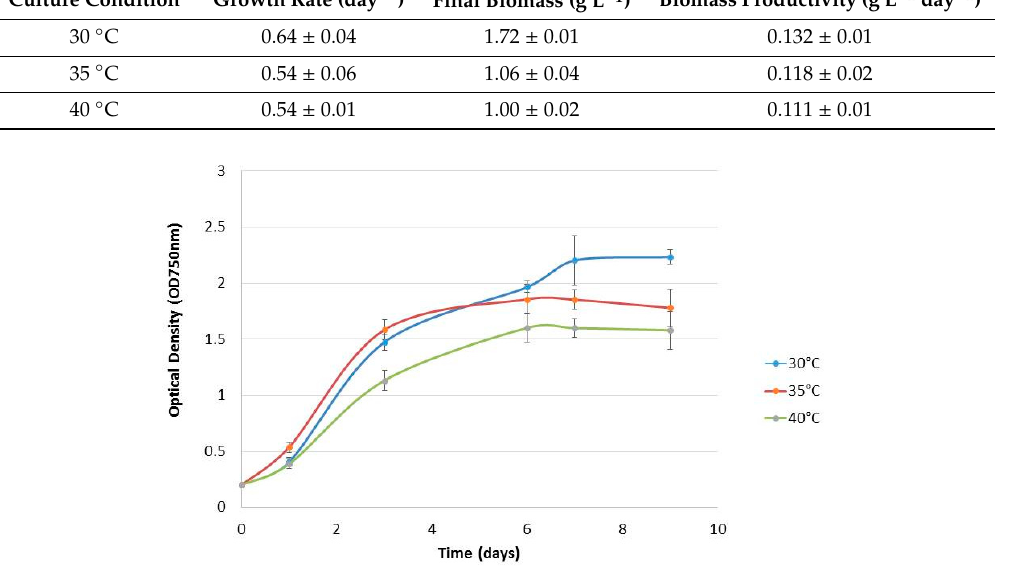
Figure 1. Growth curves of Chlorella sp. QUCCCM3 cultured under di ff erent temperatures. The points represent means ± SD of samples, n = 2.